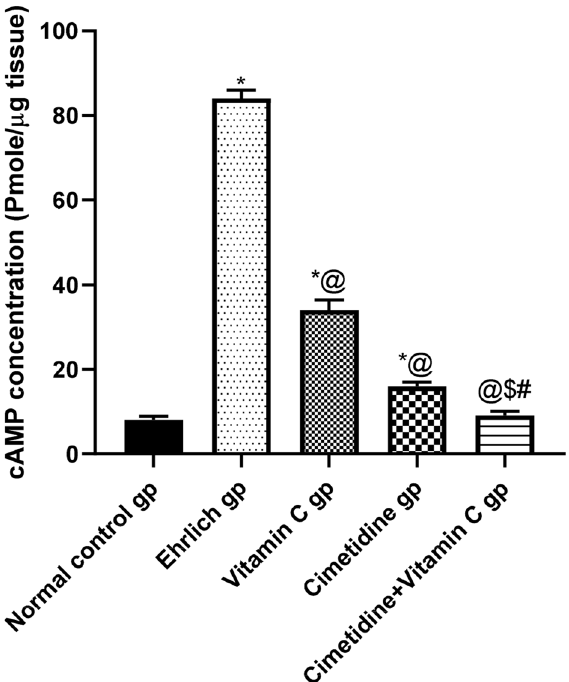
Figure 9. The changes in the tissue level of cAMP following treatment with cimetidine at a dose of 200 mg/kg/ day, vitamin C at a dose of 4 g/kg/day, and their combination for 15 days after Ehrlich induction of breast cancer in mice. Data are presented as mean ± SD.* is significantly different from the normal control group, P < 0.05. @ is significantly different from Ehrlich untreated group, P < 0.05. $ is significantly different from the vitamin C- treated group, P < 0.05. # is significantly different from cimetidine-treated group, P < 0.05.